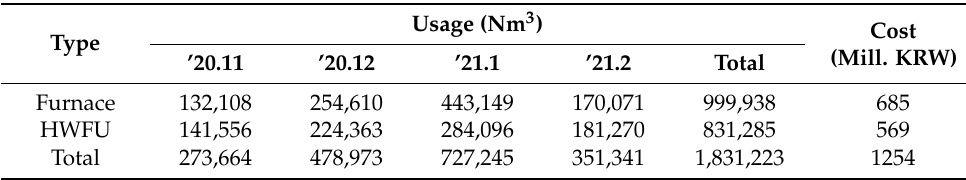
Table 5. Energy consumption of the large-scale factory in the winter season.